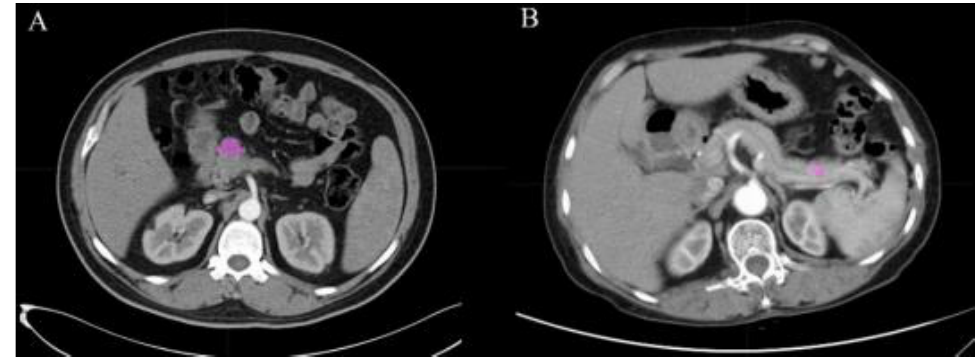
Figure 1. ROI manually drawn from two cases in CT images. ( A ) Example of a 51 year old male with PDAC with lesion in pancreatic head. ( B ) Example of a 60 year old female with pNET with lesion in pancreatic body. The pink areas in the figure are the delineated ROIs.